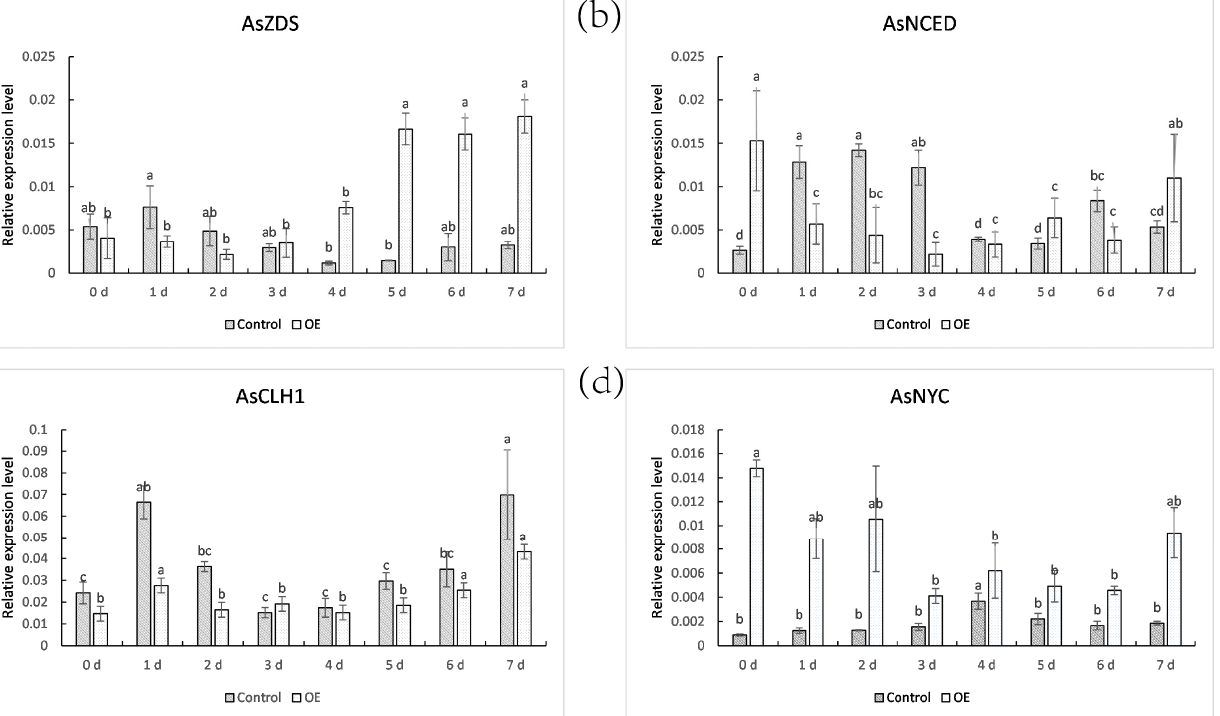
Figure 5. ZjNOL protein analysis. ( a ) The electrostatic potential distribution of ZjNOL protein. The value of electrostatic potential is positively associated with the depth of color, with blue represent- ing positive potential and red representing negative potential. ( b ) Protein structure simulation of ZjNOL. NOL proteins were phylogenetically analyzed using the neighbor-joining method and protein sequences from various species obtained from the NCBI database (Supple- mentary Figure S2A,B). The phylogenetic tree reflects the valid taxonomy of the included species. ZjNOL has the most homology with NOL of Zea mays and all the other monocots above them. Although AtNOL does not have the highest resemblance with AtNOL from Arabidopsis thaliana, their motif architectures are similar (Supplementary Figure S2B).